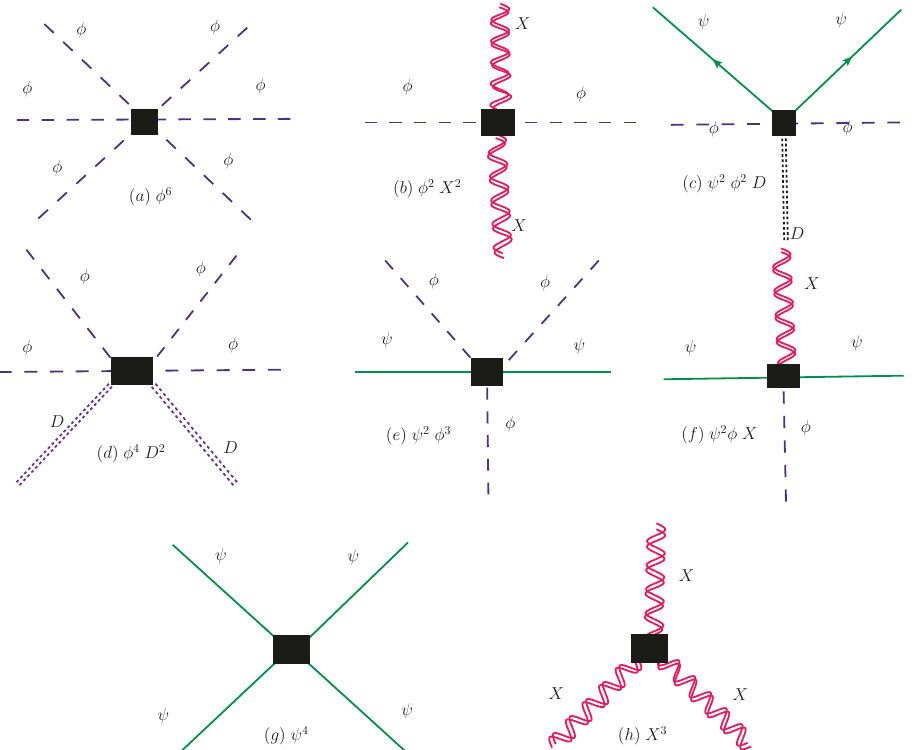
Figure 3. E(cid:11)ective operators in \Warsaw"-like basis representing the following class of operators: (a) (cid:30) 6 [42 2 + 28 = 112], (b) (cid:30) 2 X 2 [62], (c) 2 (cid:30) 2 D [20 + 8 (cid:2) 2 (cid:30) 3 [22 2 = 44] (Majorana type) + [36 (cid:2)